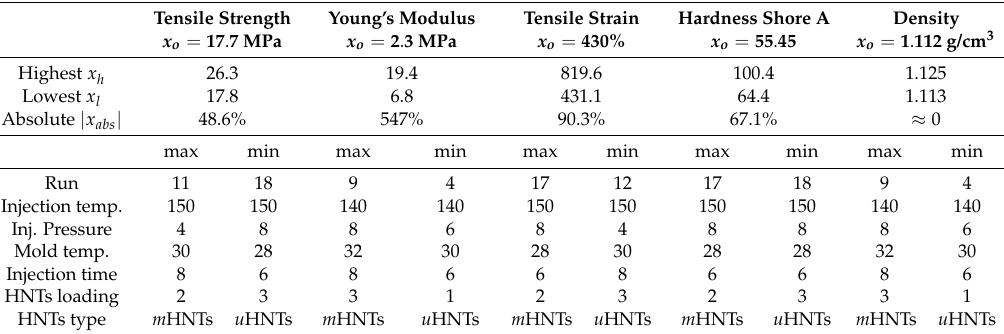
Table 3. Absolute variation of the actual